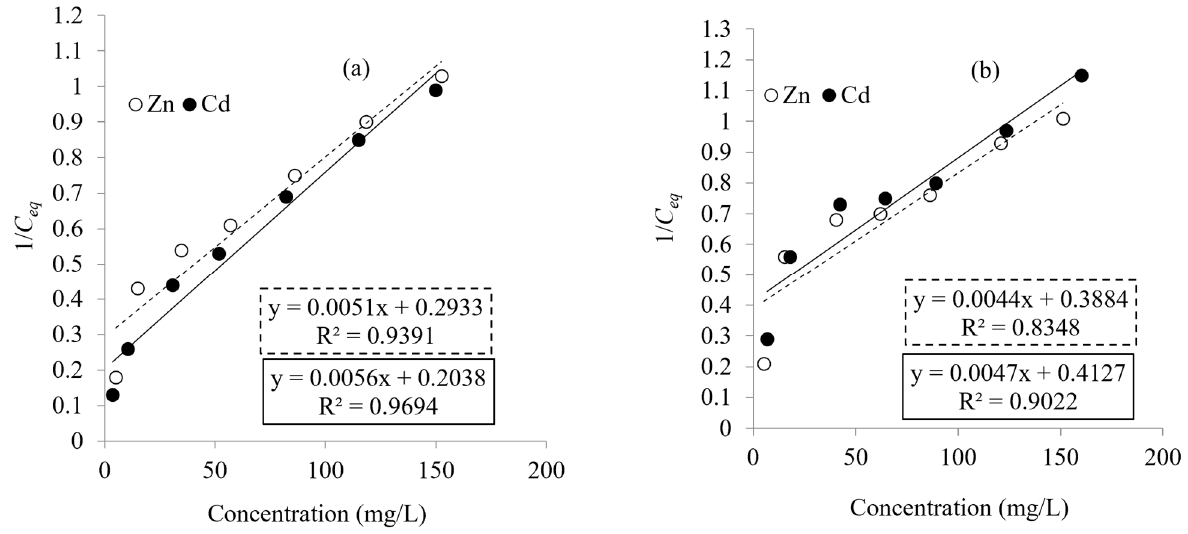
Figure 6. Linear form of Langmuir adsorption isotherms for adsorption of Zn 2+ and Cd 2+ by living ( a ) and lyophilized ( b ) cells of Priestia megaterium PRJNA526404. Table 2. Langmuir and Freundlich adsorption constants calculated from the Langmuir adsorption isotherms of Zn 2+ and Cd 2+ by living and lyophilized biomass of Priestia megaterium